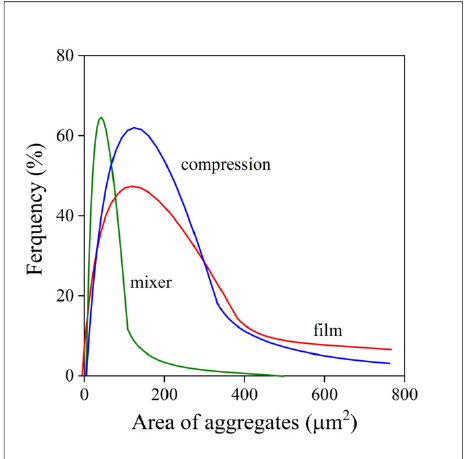
Figure 3. Size distribution of aggregates in PCL/halloysite composites at 5 vol% filler content. Effect of homogenization technology.